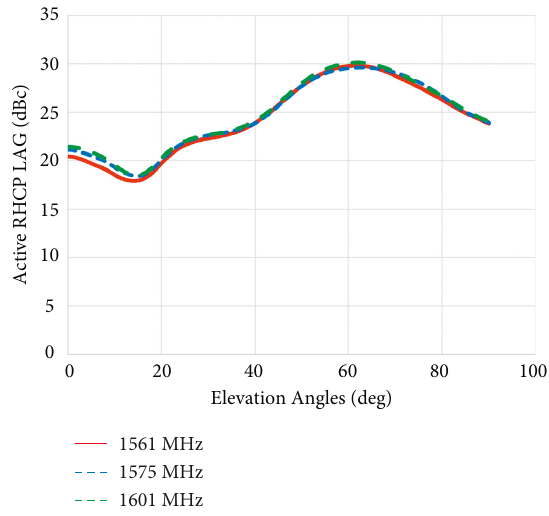
Figure 21: Measured GNSS active RHCP LAG on a